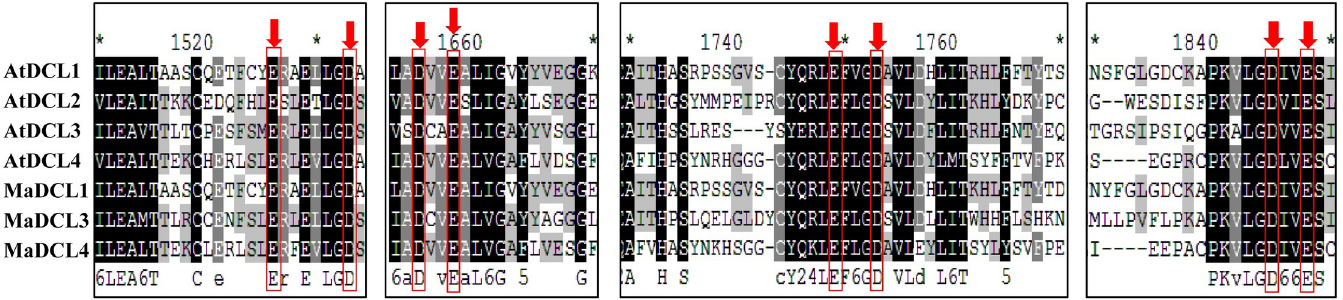
Fig 2. The multiple sequence alignment analysis of RNase III domains (RIBOc I and II) of the aa sequences of M . acuminata and Arabidopsis DCL proteins by Clustal-W program in MEGA 11. The downward red arrows indicate the position of conserved The two RNase III domains at the glutamate (E), aspartate (D), glutamate (D), aspartate (E) (EDDE)